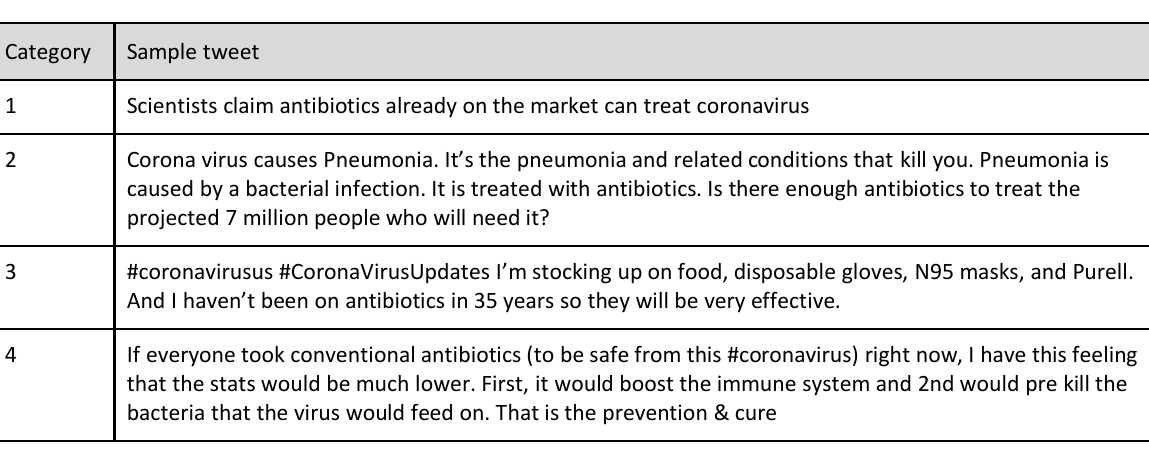
Table 1. A list of identified tweets that contain misinformation about COVID-19 and